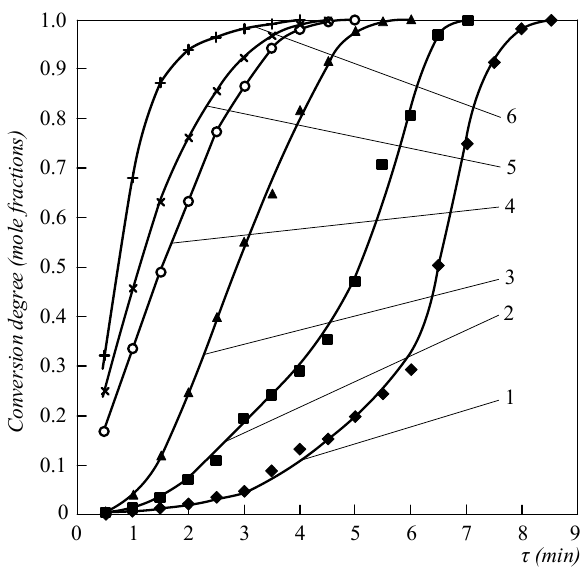
Figure 4. The effect of the time and temperature of fluorination on the degree of conversion in the titanium “dioxide-fluorine” system. 1—580; 2—630; 3—680; 4—730; 5—780; 6—830 K. The obtained values of the accuracy of the approximation R 2 , of the activation energy E a , of the pre-exponential coefficient k 0 are presented in Table 1.